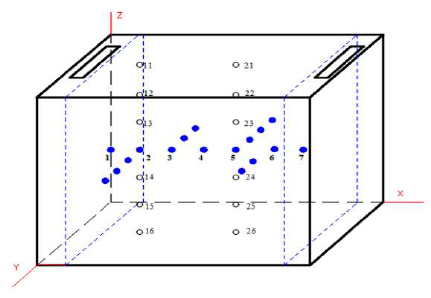
Figure 2. Topology of the temperature measurement sensor layout.